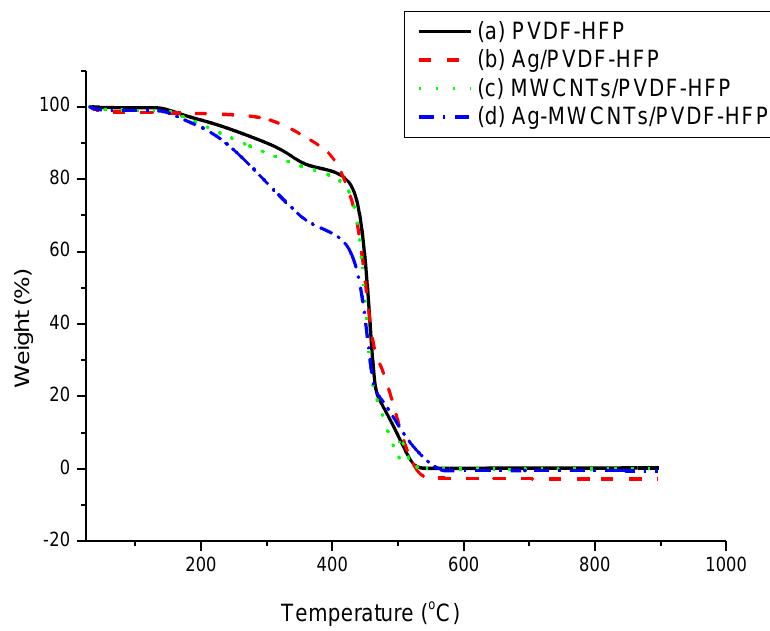
Figure 3. Thermogravimetric analysis (TGA) of ( a ) PVDF-HFP, ( b ) Ag/PVDF-HFP, ( c ) MWCNTs/PVDF-HFP ( d ) Ag-MWCNTs/PVDF-HFP.